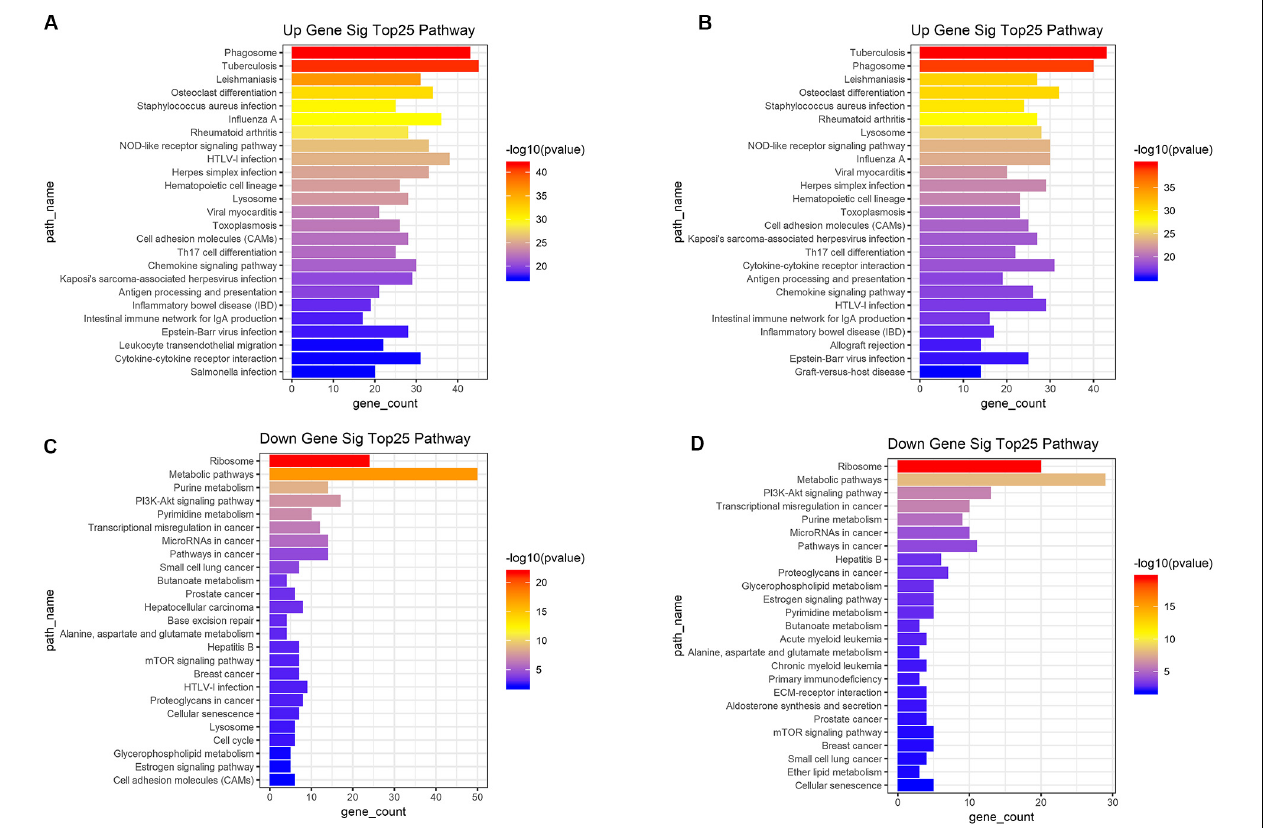
FIGURE 4 | Top 25 KEGG pathway analysis were performed for functional enrichment clustering analysis. (A) Top25 significant KEGG pathways based on upregulated genes in immune scores. (B) Top25 significant KEGG pathways based on upregulated genes in stromal scores. (C) Top25 significant KEGG pathways based on downregulated genes in immune scores. (D) Top25 significant KEGG pathways based on downregulated genes in stromal scores. KEGG, Kyoto Encyclopedia of Genes and